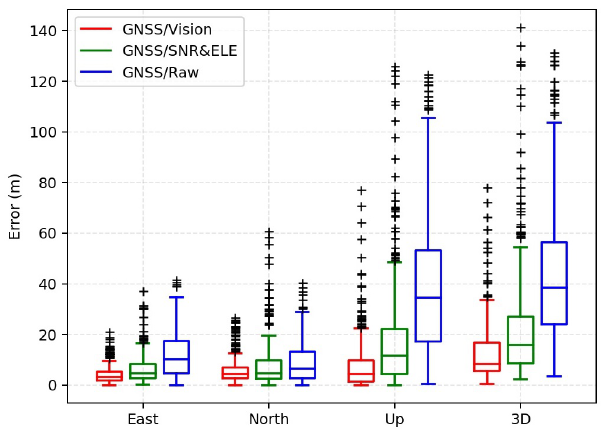
Figure 20. Boxplots of the positioning